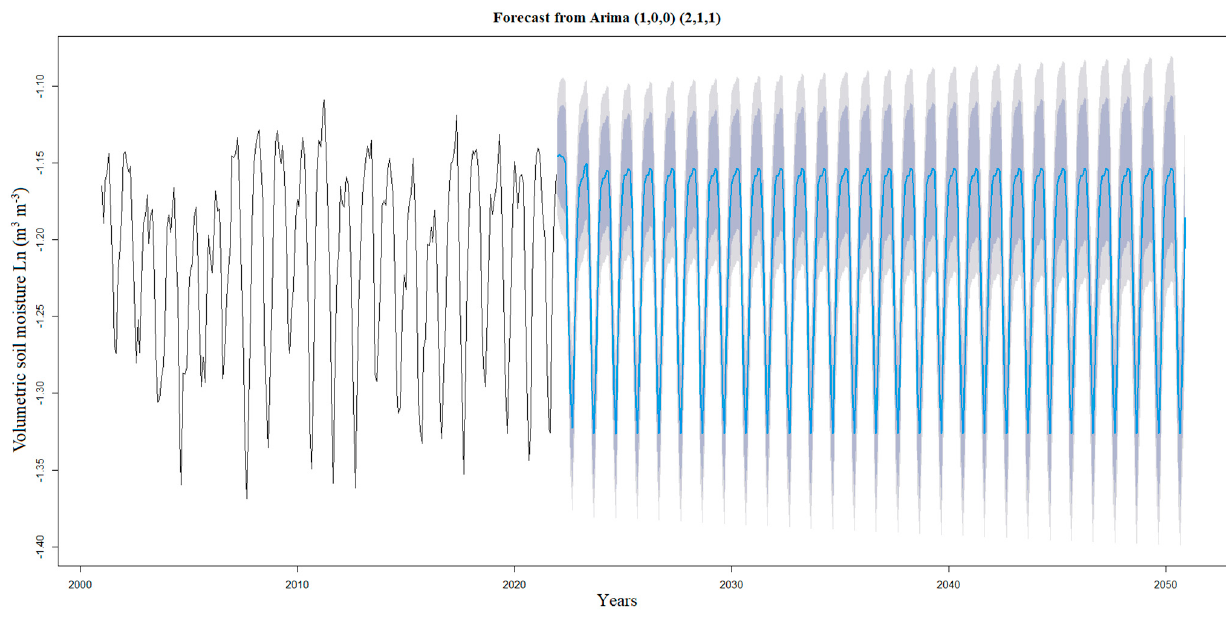
Figure 10. Past time series (2001–2021) observed from the VSM (m 3 m − 3 ) and future time series in blue (2022–2050) through ARIMA modeling. The vertical axis is on a logarithmic scale